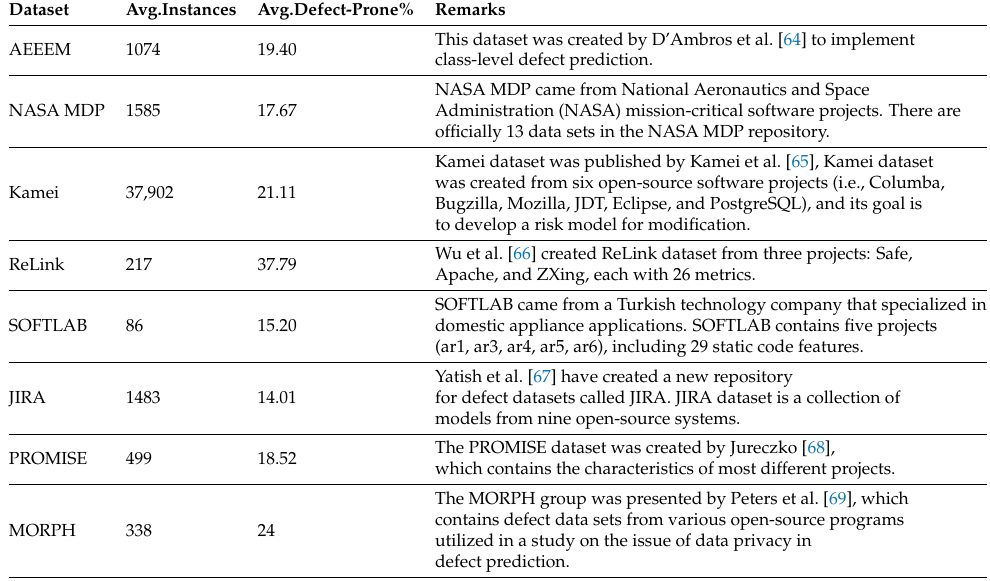
Table 4. Available labeled